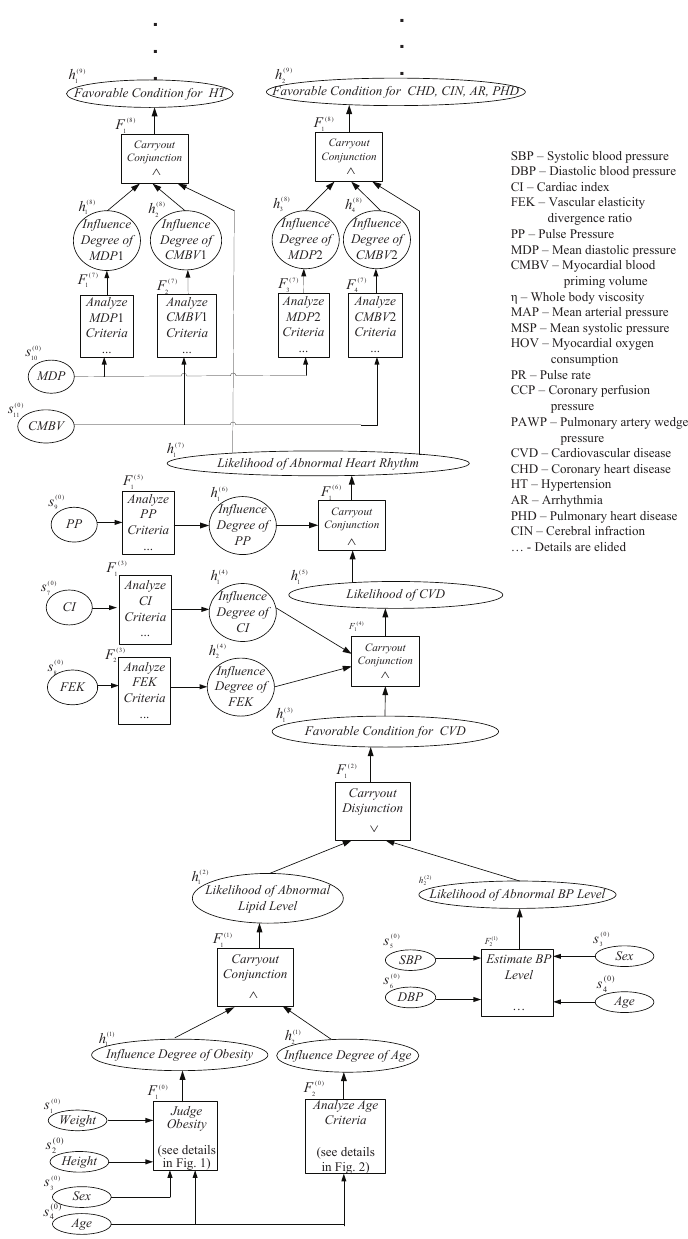
Figure 7. Partially constructed HBFIN for diagnosing